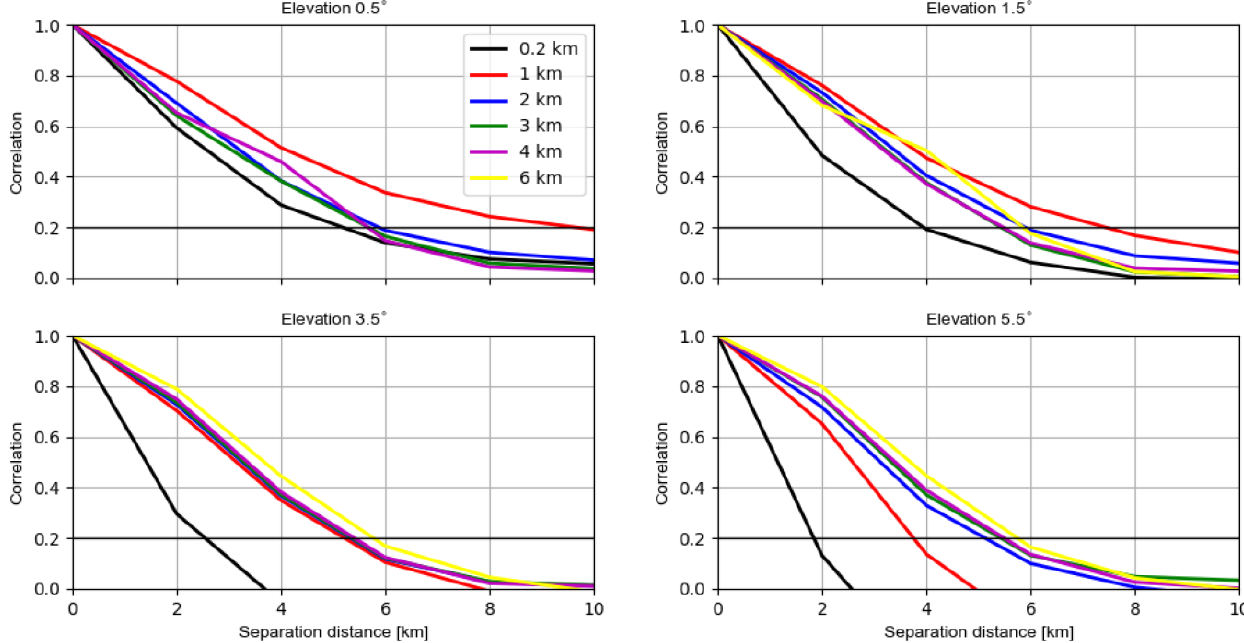
Figure 8. The same as Fig. 6 but for radial